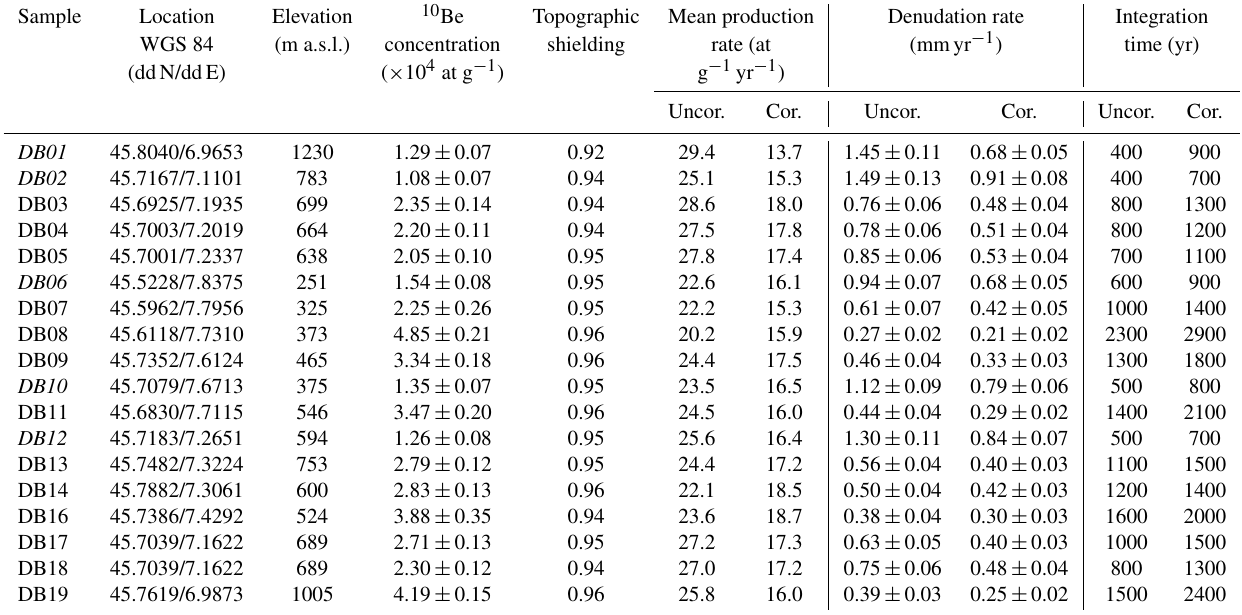
Table 1. River-sediment sample locations, measured 10 Be concentrations, calculated mean catchment 10 Be production rates, and output denudation rates and apparent ages. Sample coordinates are given in decimal degrees (dd), and sample names collected along the main DB river are written in italics. Production rate estimates (and derived denudation rates and apparent ages) are provided for (1) topographic shielding correction (column labelled “Uncor.”) and (2) including corrections for topographic shielding, snow and LIA glacier shielding and for quartz content (column labelled “Cor.”). Mean catchment 10 Be production rates (and derived catchment denudation rates) obtained by applying each individual correction are reported in Table S2.